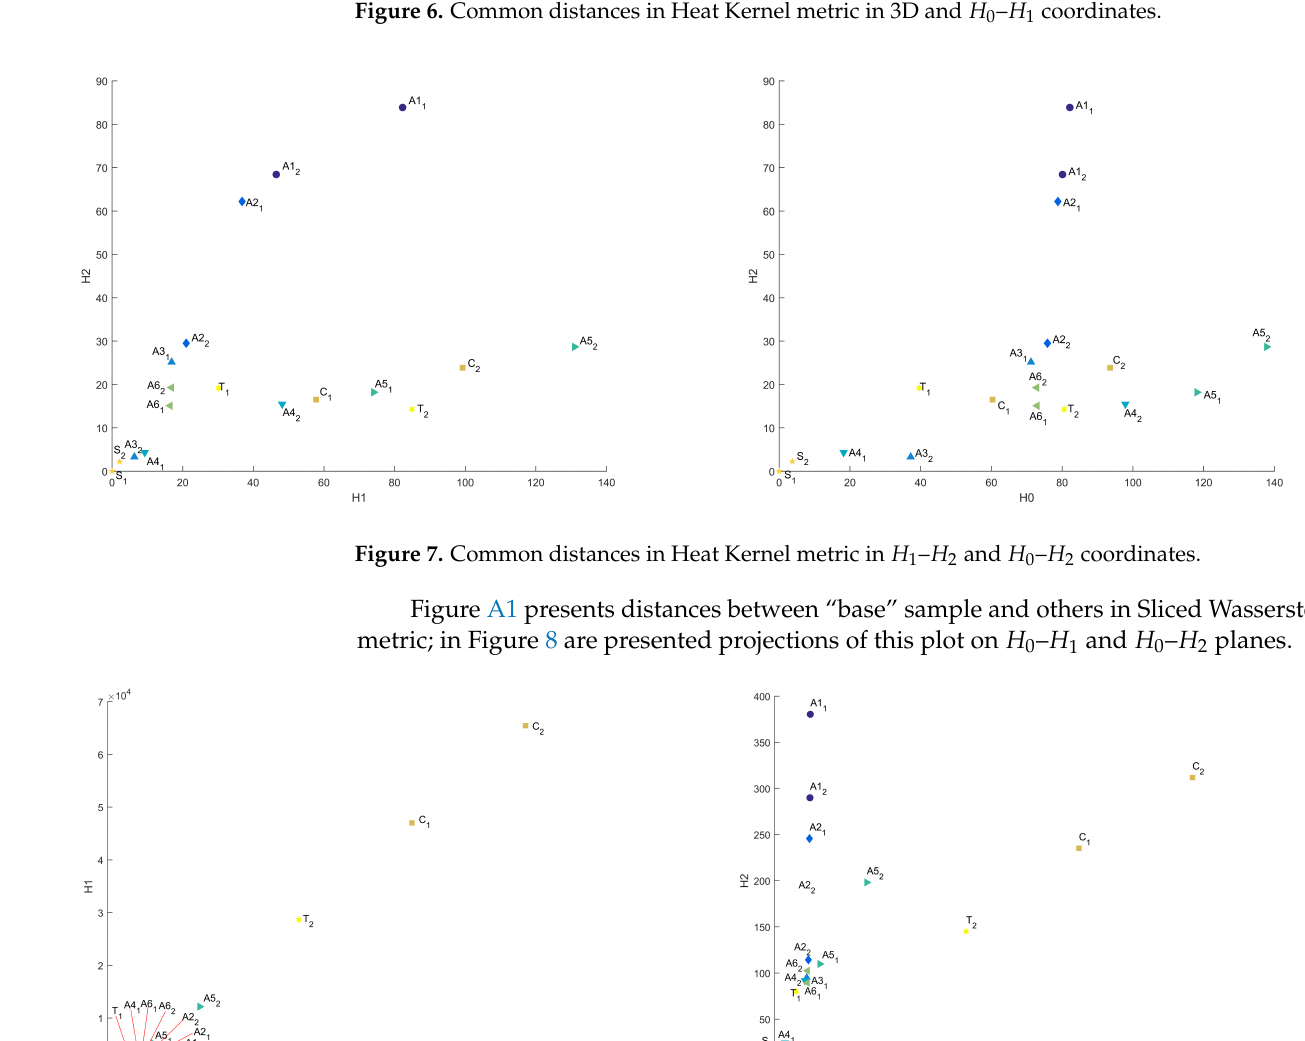
Figure 6. Common distances in Heat Kernel metric in 3D and H 0 – H 1 coordinates.